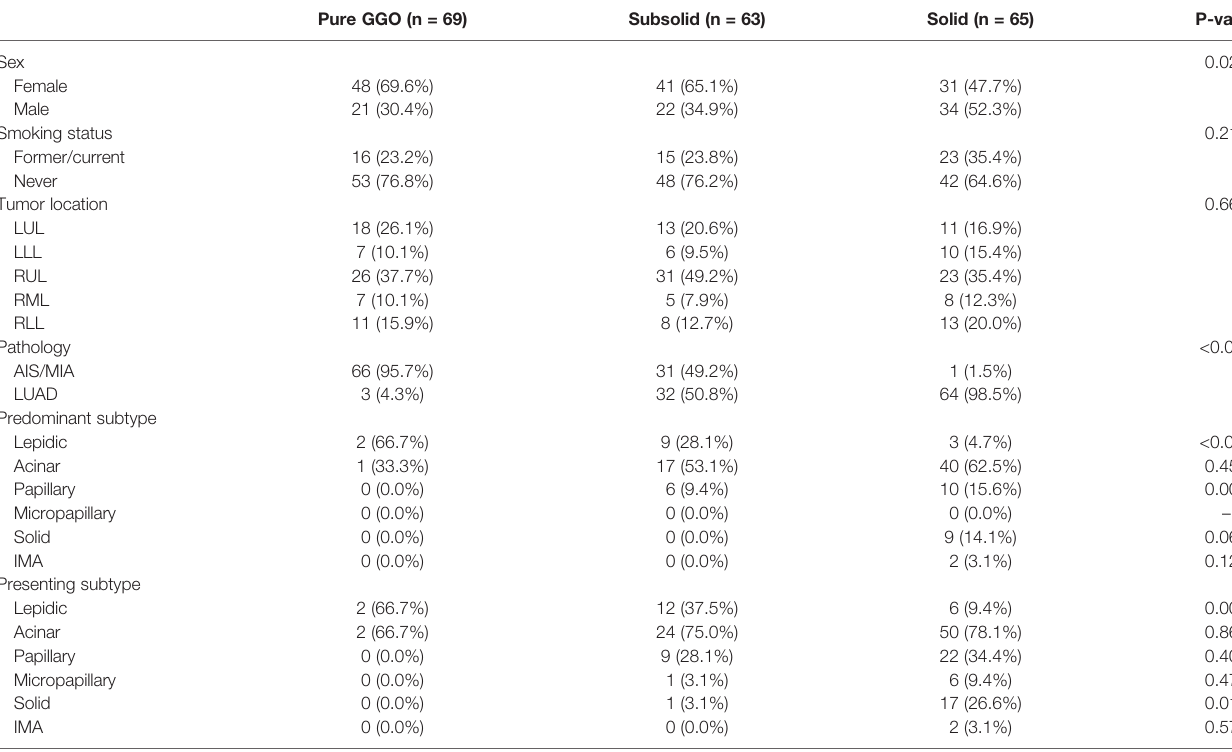
TABLE 1 | Clinical and pathological characteristics of the study cohort (n =